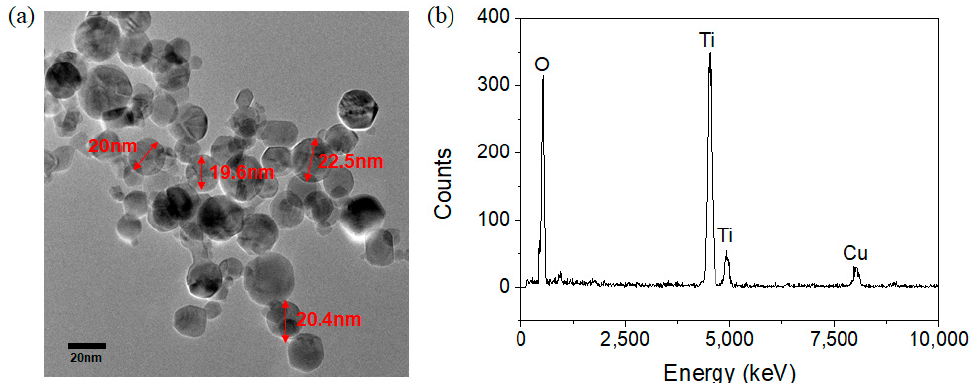
Figure 2. ( a ) TEM image of TiO 2 nanoparticles synthesized by the thermal plasma process and ( b ) EDX data of TiO 2 nanoparticles synthesized by the thermal plasma process.